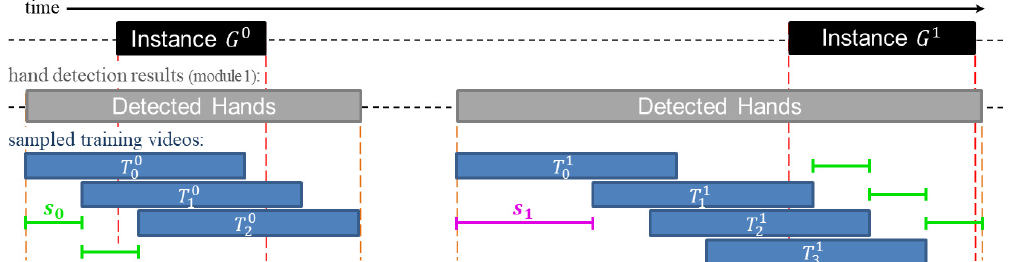
Figure 5. A representation of the adaptive sampling of training videos. ( left ) Training videos that overlap with a truth instance are sampled with stride s 0 . ( right ) Training videos that do not overlap with any truth instance are sampled with stride s 1